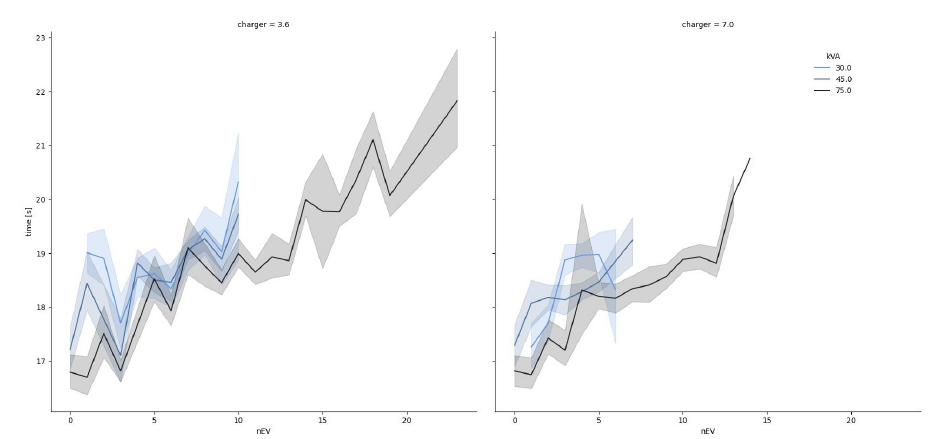
Figure 13. Processing time results for the number of EVs—Feeder